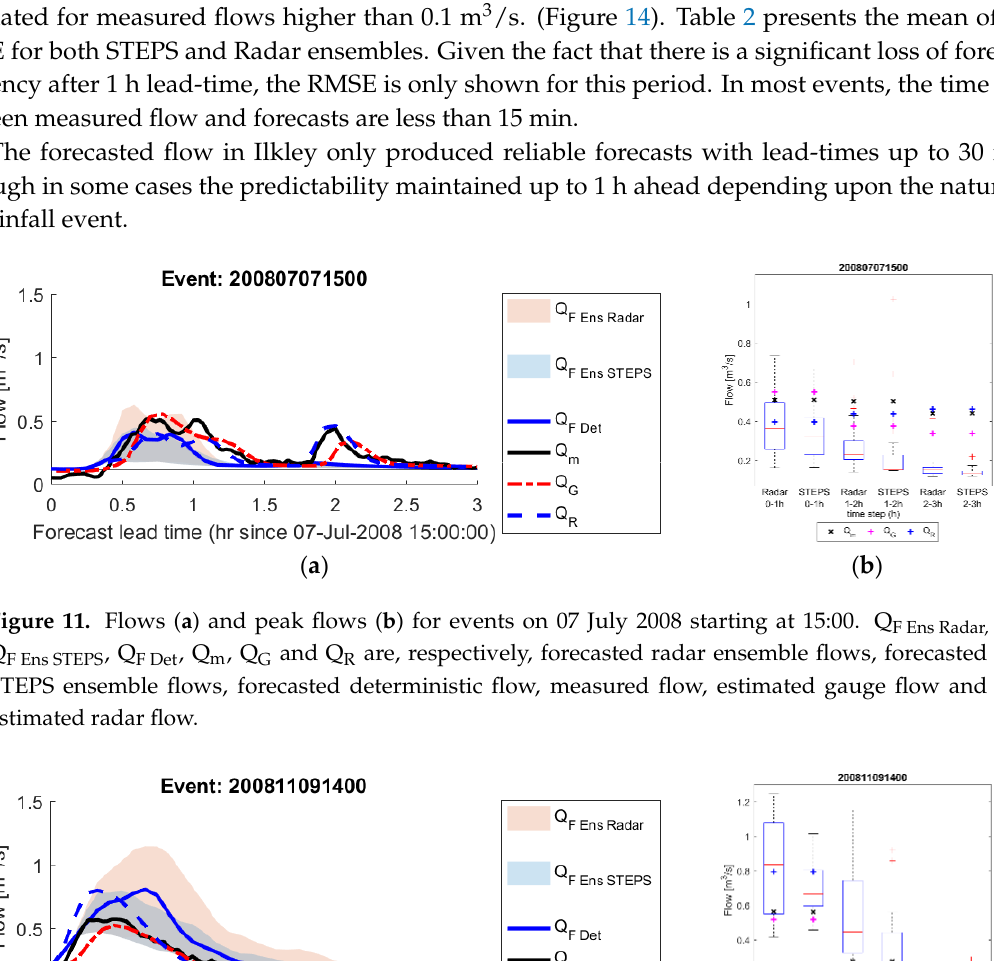
Figure 10. Measured flows (Q m ) and gauge simulated flows (Q G ) from 1 July 2008 until 30 September 2008.